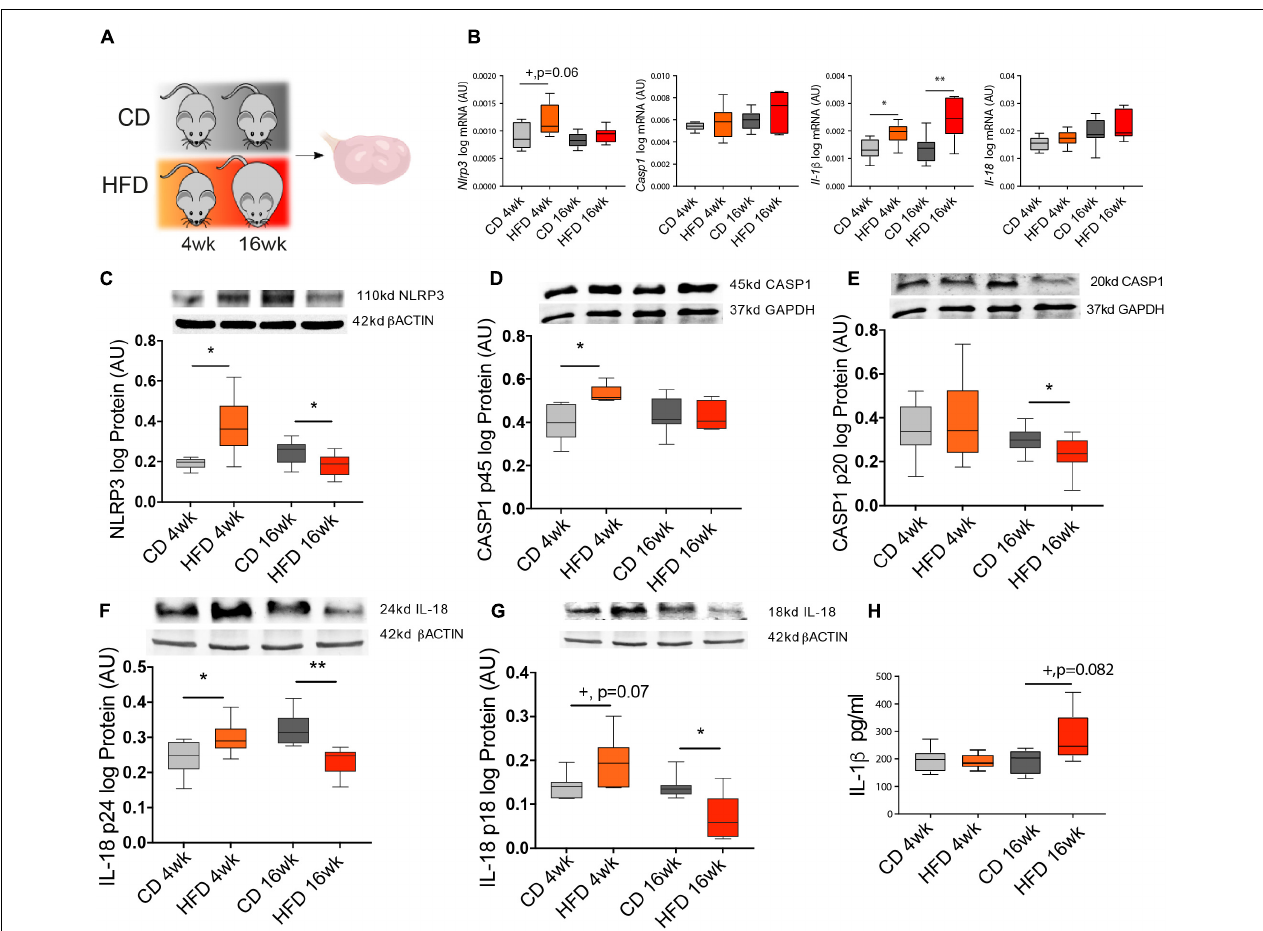
FIGURE 2 | Diet-induced obesity (DIO) changes NLRP3 expression in the ovary. (A) Experimental design: Mice were fed either chow diet (CD) or high-fat diet (HFD) for 4 or 16 weeks (wk) and ovaries were collected during the diestrus stage. Quantification of (B) Nlrp3 , Casp1 , Il-1 β , and Il-18 mRNA by real-time PCR. Abundance of (C) NLRP3, (D) pro CASP1 p45, (E) CASP1 p20, (F) pro IL-18 p24, (G) IL-18 p18 protein measured by Western blotting and (H) IL-1 β protein measured by enzyme-linked immunosorbent assay (ELISA) in ovarian extracts collected from DIO mice. mRNA level was normalized with ribosomal protein L37 ( Rpl37 ) value and protein expression with β -actin or glyceraldehyde 3-phosphate dehydrogenase (GAPDH) level. Bars represent mean ± SEM. Differences between control and treatment groups analyzed with Mann–Whitney in real-time PCR and ELISA and multiple t -test for Western blotting. Number of samples: n = 6–8 for real-time PCR, n = 7–8 for immunoblots, and n = 4–6 for ELISA. Asterisks indicate significant differences (* p < 0.05; ** p < 0.01; + p = 0.06; + p = 0.07 or + p = 0.082—all values indicated). AU, arbitrary